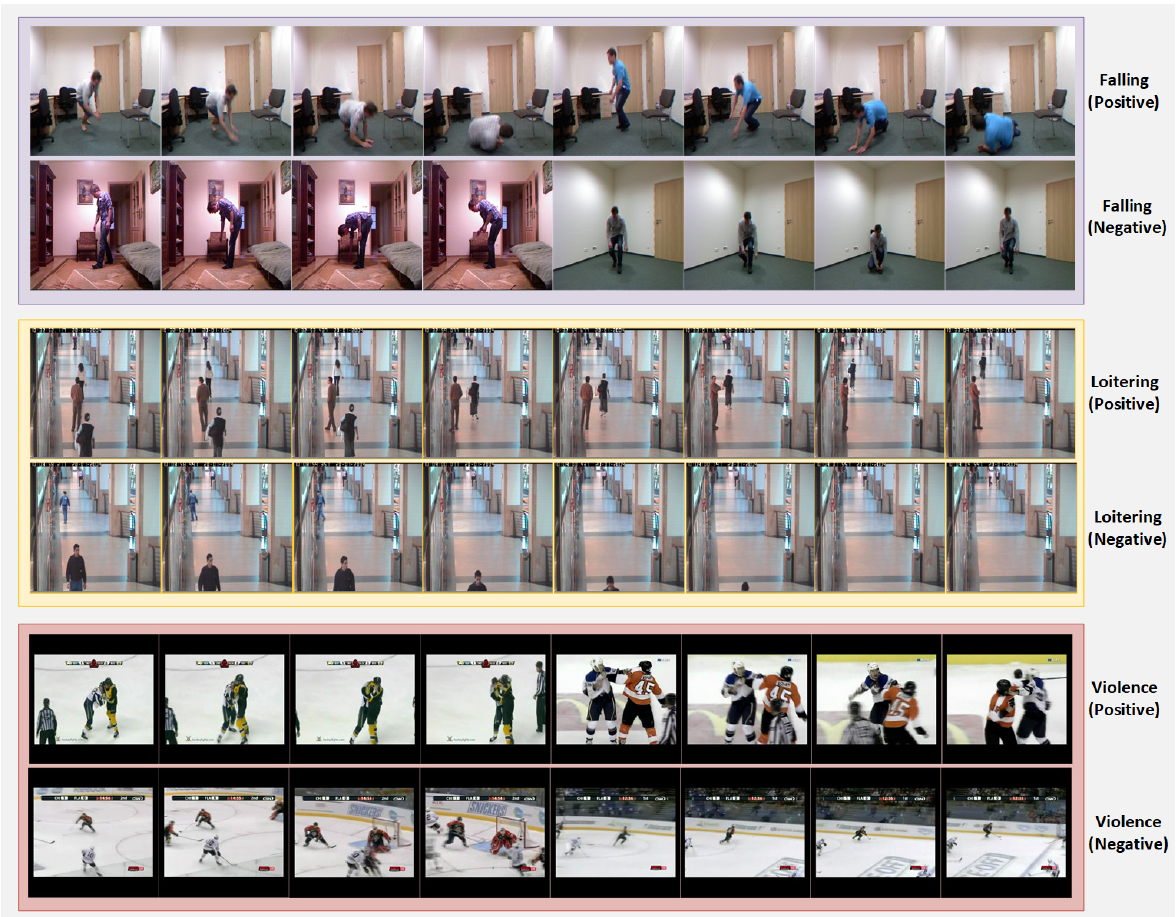
Figure 2. Sample of frame sequences taken from videos containing negative and positive examples of each action class.